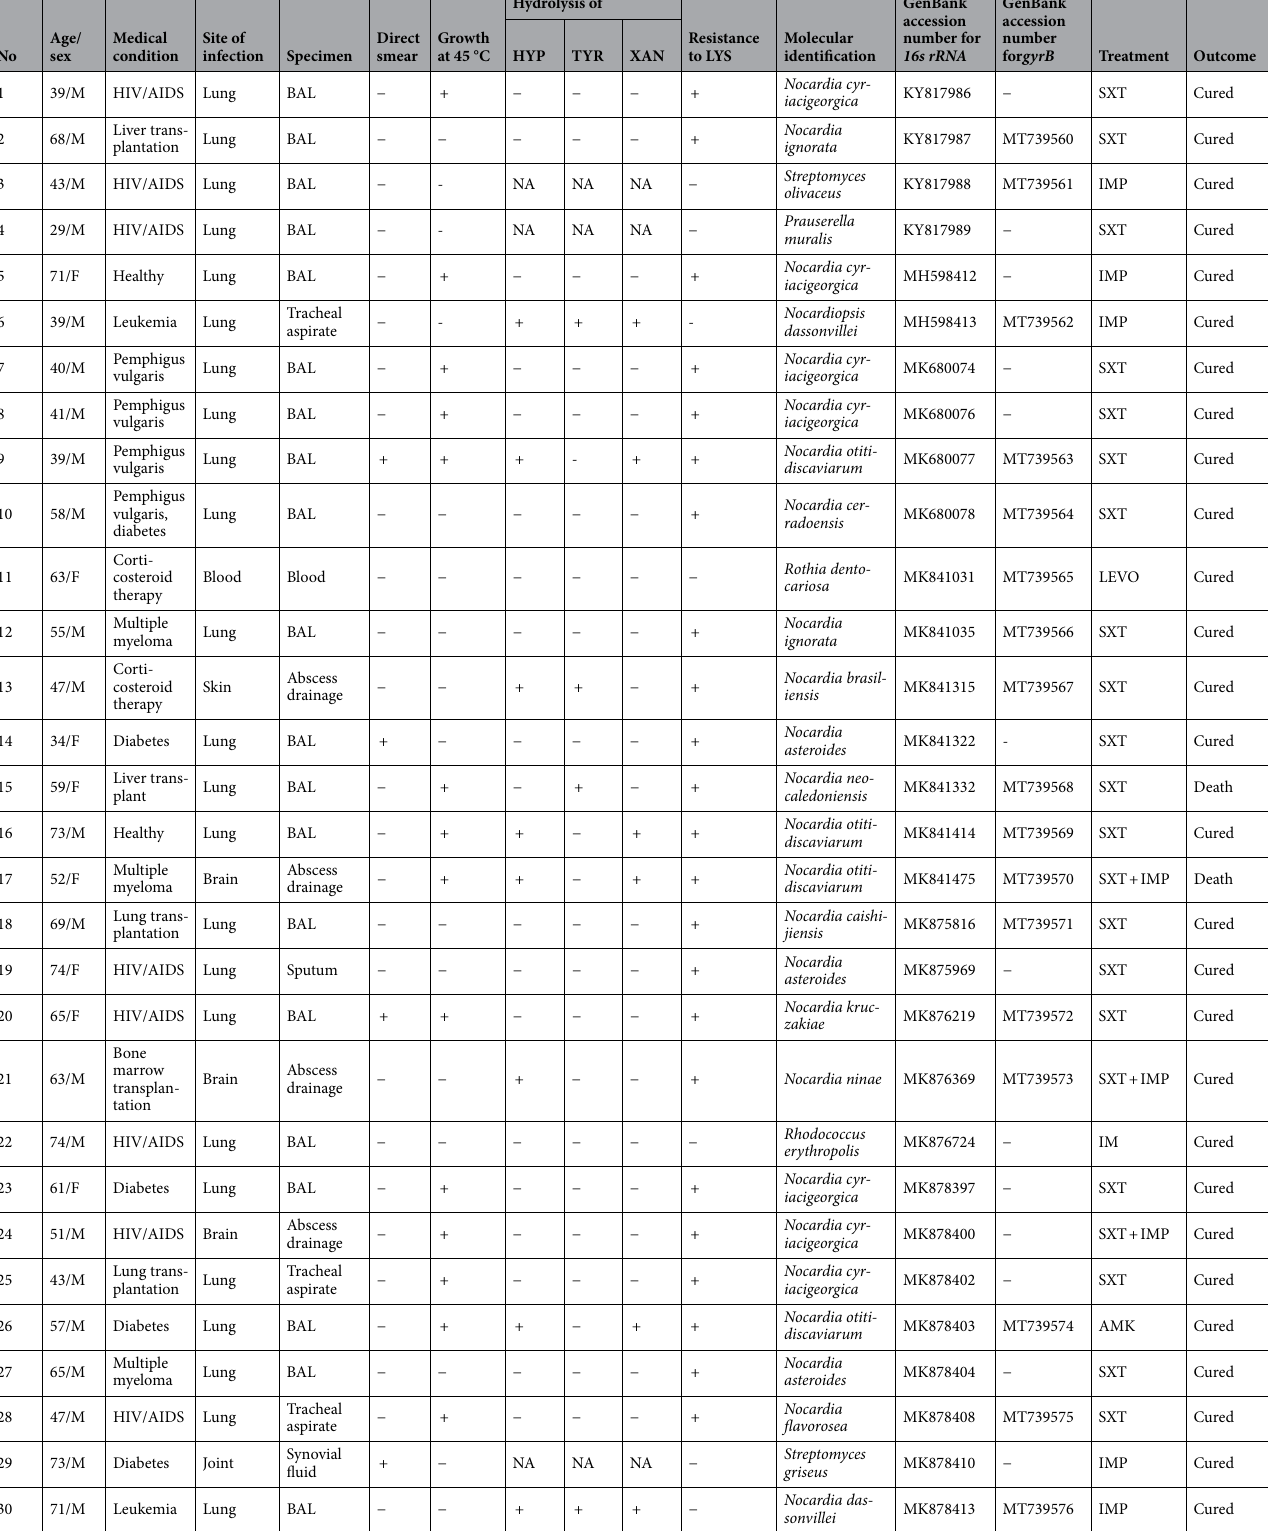
Table 1. Baseline characteristics of patients, underlying conditions, laboratory findings, causative agents, treatment and outcome of 30 cases of actinomycetes infection. M male, F female, BAL bronchoalveolar